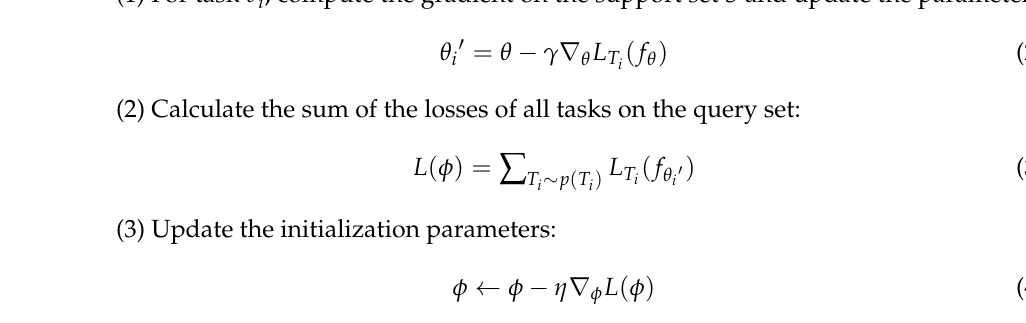
Figure 3. Descend to the global optimum.